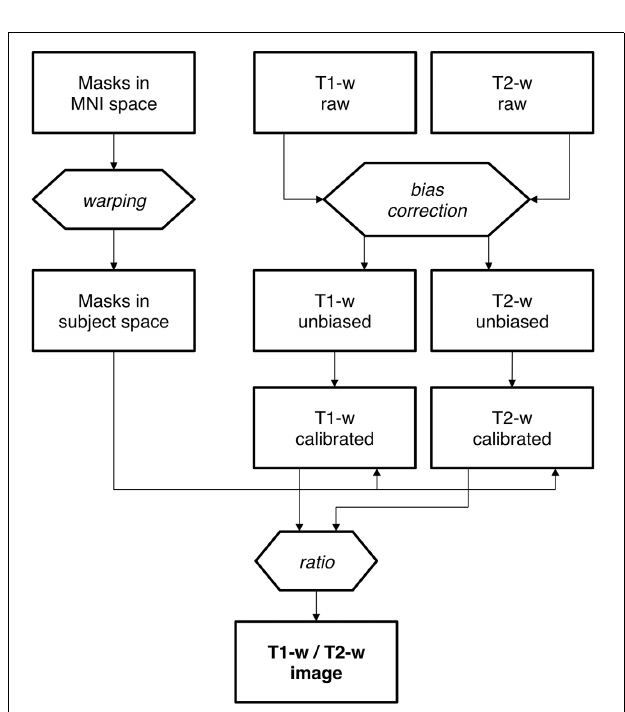
conventional MRI images have arbitrary intensity scales, the three images are showed with a colormap assigned on the basis of the 10 and 90th percentile values. The subject used for this figure is Subject 30 of the KIRBY21 database.